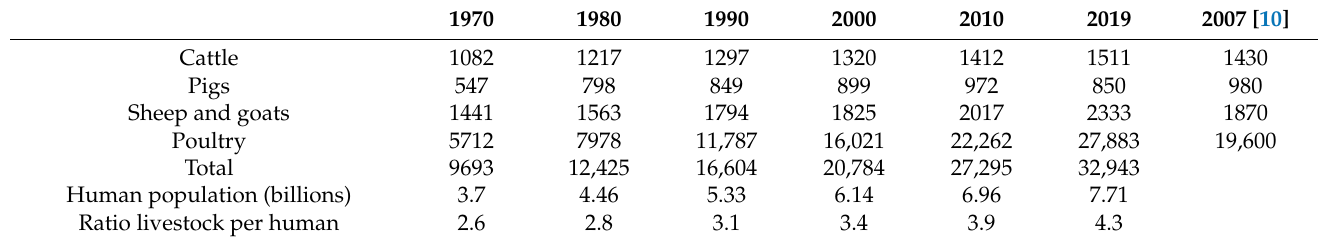
Figure 1. Global livestock numbers for selected species (in millions) for 1970–2019 (as bars) [12] and for 2007 (shown as the diamond symbol) [10]. Total is the number of animals from each species listed plus rabbits, ducks, turkey, rodents, horses, buffalo, and asses. Global numbers of livestock have tripled over the last 50 years to 2019 [12] (Table 1 Globally, agriculture and waste are the dominant source (62%) of anthropogenic (hu- and Figure 1) and now represent ~60% of total mammalian biomass [13]. The growth man-caused) CH 4 emissions, the total of which is larger than all natural CH 4 emissions [6]. in the number of livestock approximates an exponential fit (Figure 1) and represents an increase in the number of livestock per head of human population from 2.6 in 1970 to 4.3 in 2019 (Table 1). Table 1. Global livestock numbers for selected species (in millions) for 1970–2019 [12] and for 2007 [10]. Total includes rabbits, ducks, turkey, rodents, horses, buffalo, and asses. Human population taken from